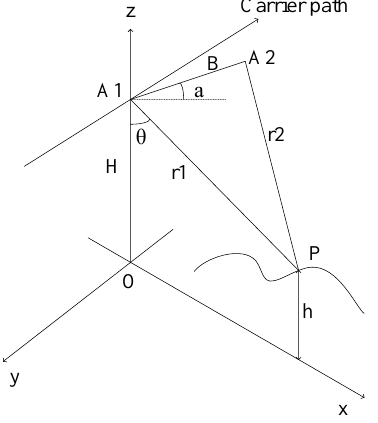
Figure 1. Figure placement and numbering A 1 and 𝐴 2 are primary and secondary antennas on the flight platform, and B is baseline vector,α is baseline angle, and θ is the angle of observation at the ground target point